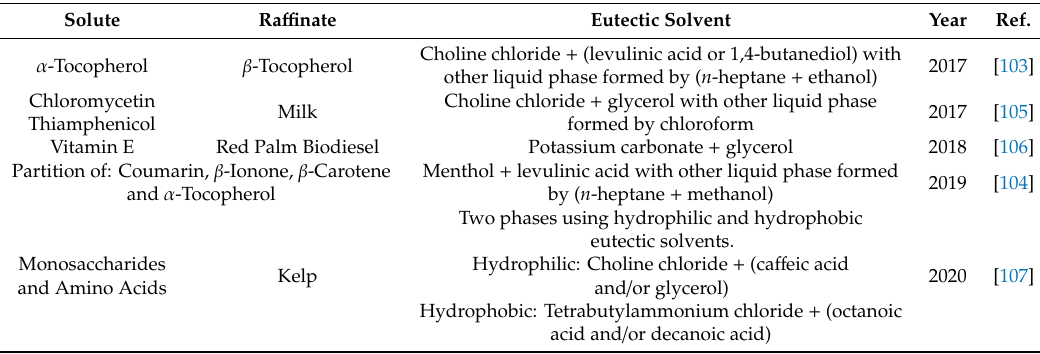
Table 6. Eutectic Solvents in the Separation of Value-added Compounds Solute Ra ffi nate Eutectic Solvent